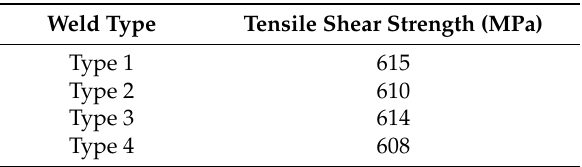
Table 4. Tensile shear strength of the four weld types.